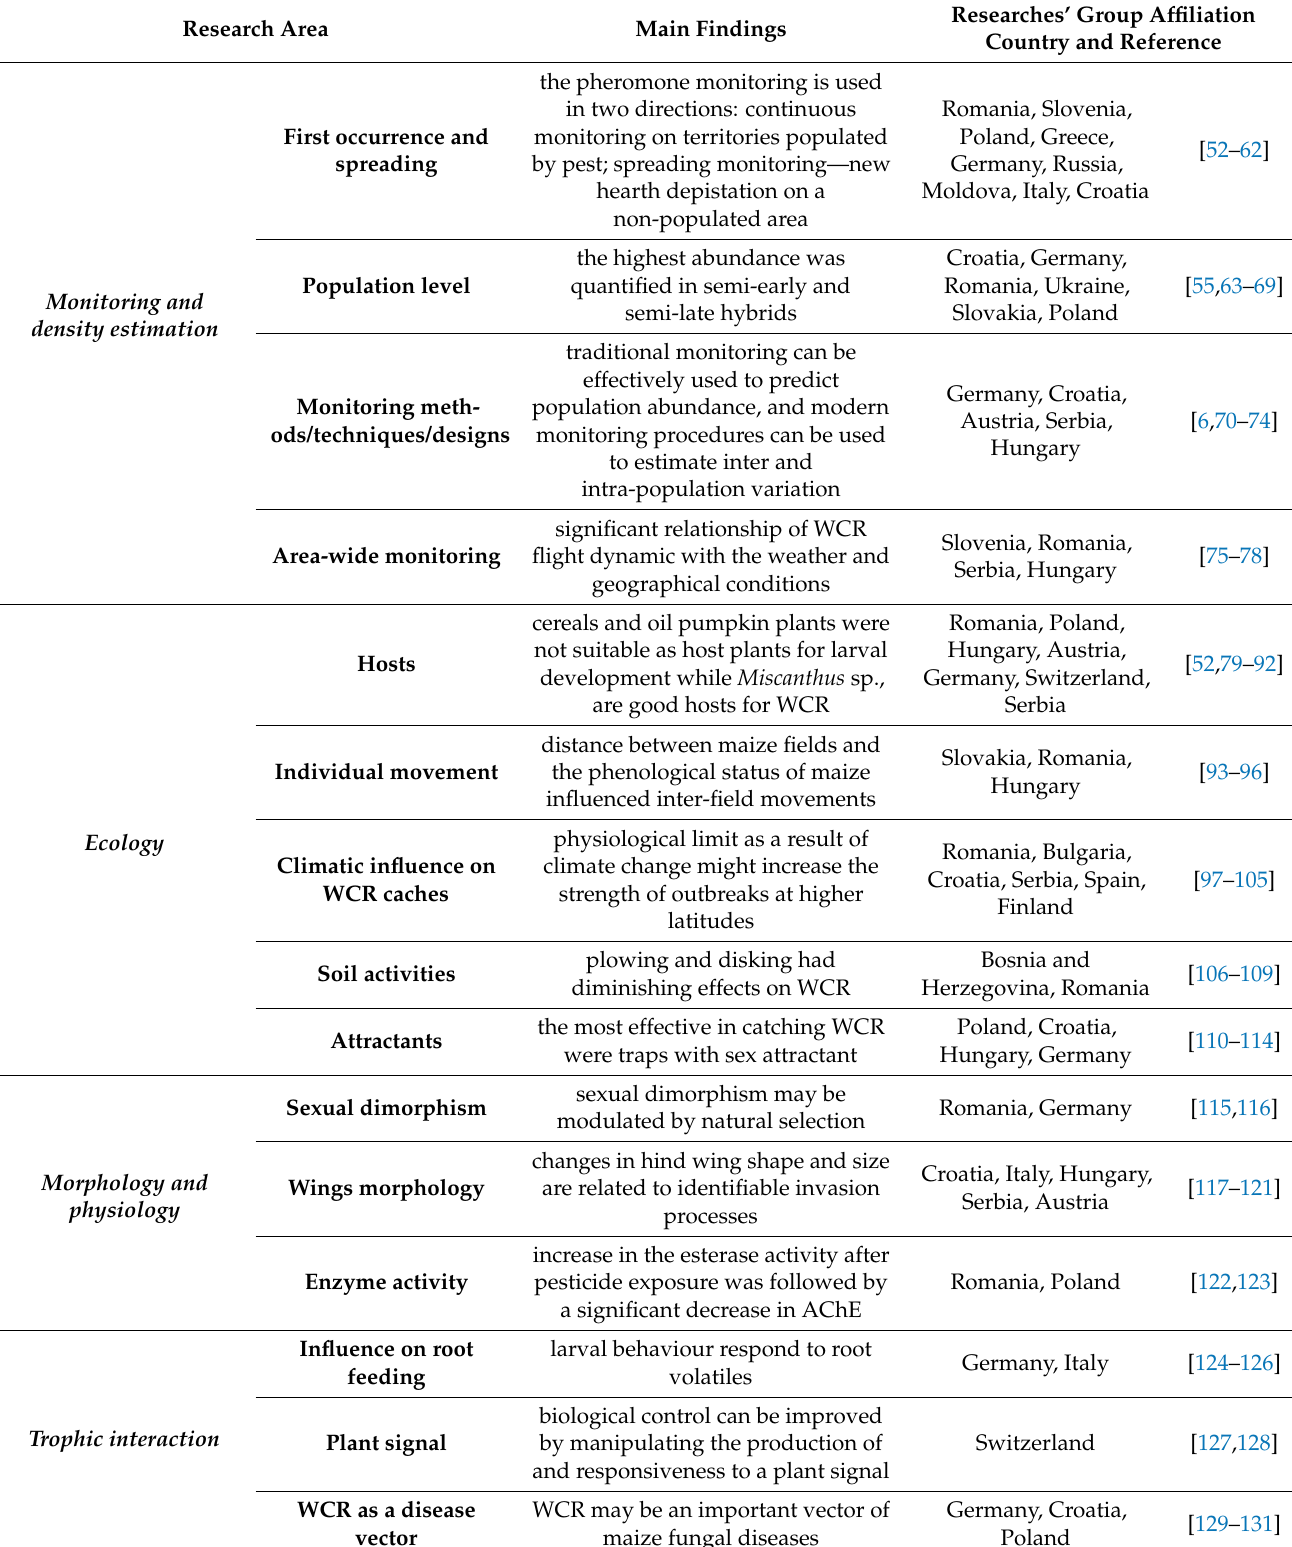
Table 1. Overview of the WCR research topics with their main findings and research groups from Europe in the period